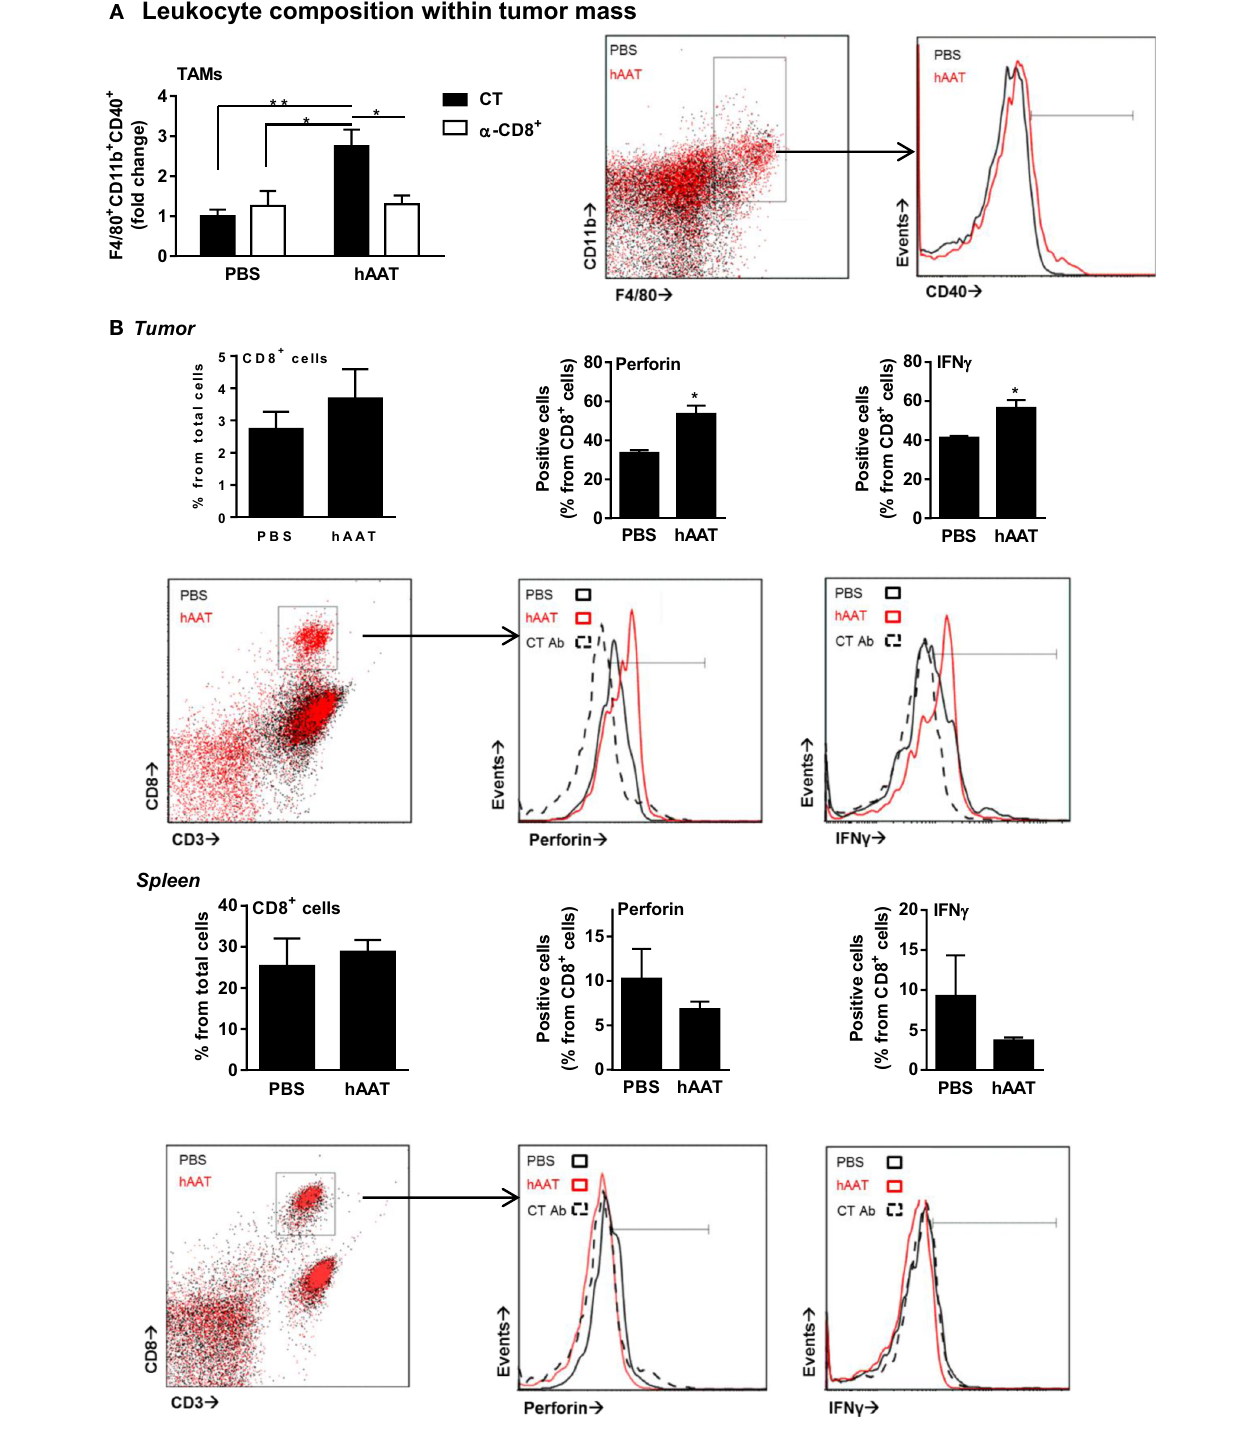
FigUre 4 | increased activation marker expression by rMa tumor-infiltrating leukocytes in haaT-treated mice . (a) PBS- and hAAT-treated RMA tumor-bearing mice ( n = 4 per group) were sacrificed 13 days after RMA cell inoculation (1 × 10 5 cells per animal, s.c.). Tumors were dissociated, and cell populations were stained for indicated markers. (B) Tumors and spleens of RMA tumor-bearing animals were dissociated, and T cell populations were stained and analyzed by flow